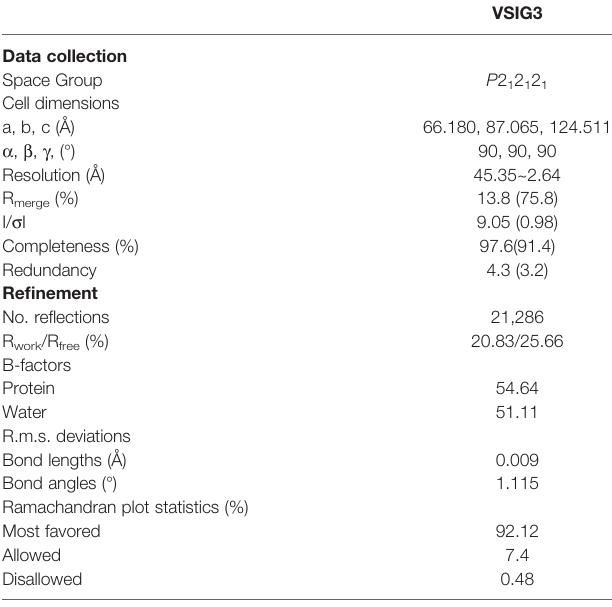
TABLE 1 | Data collection and re fi nement